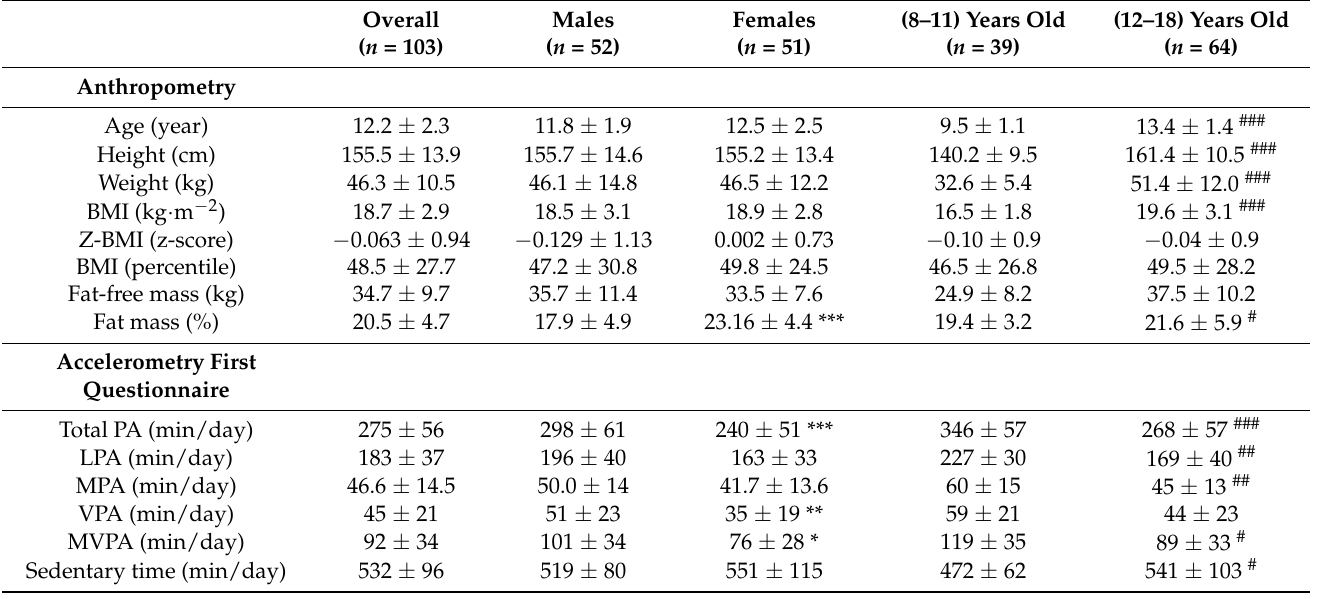
Table 1. Characteristics of the